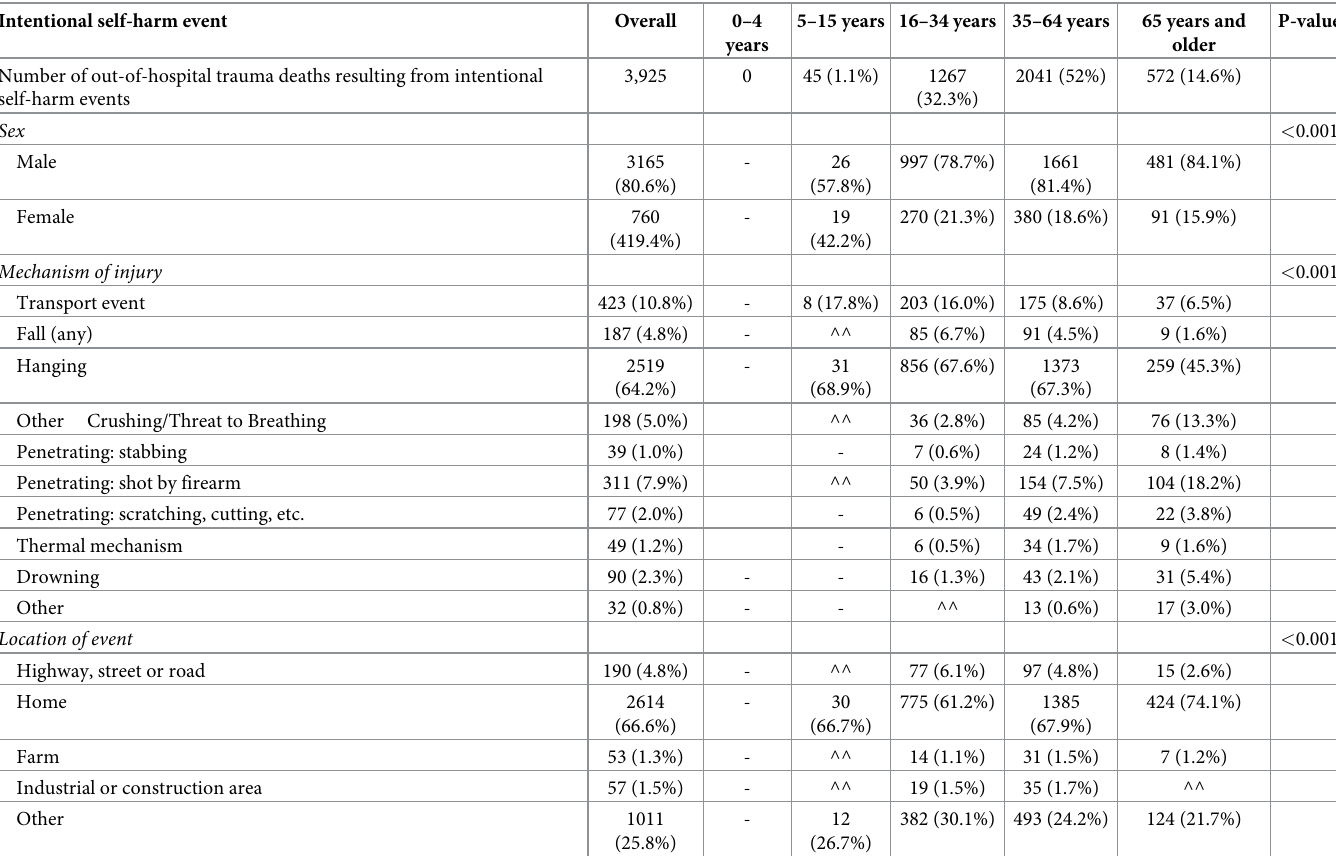
Table 5. Cause of injury and location of event of cases by age group for out-of-hospital trauma deaths resulting from intentional self-harm